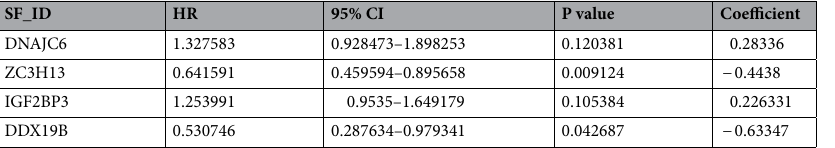
Table 3. The final prognostic risk score model for HCC patients. HCC hepatocellular carcinoma, SF splicing factor, HR hazard ratio, CI confidence